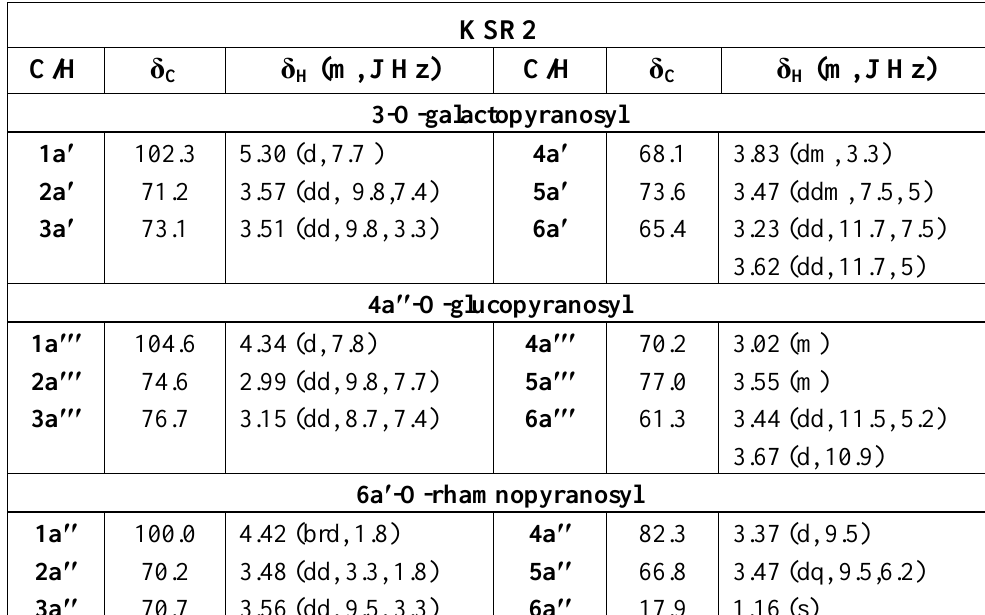
O, 13 C:125 MHz; 1 H: 500 2